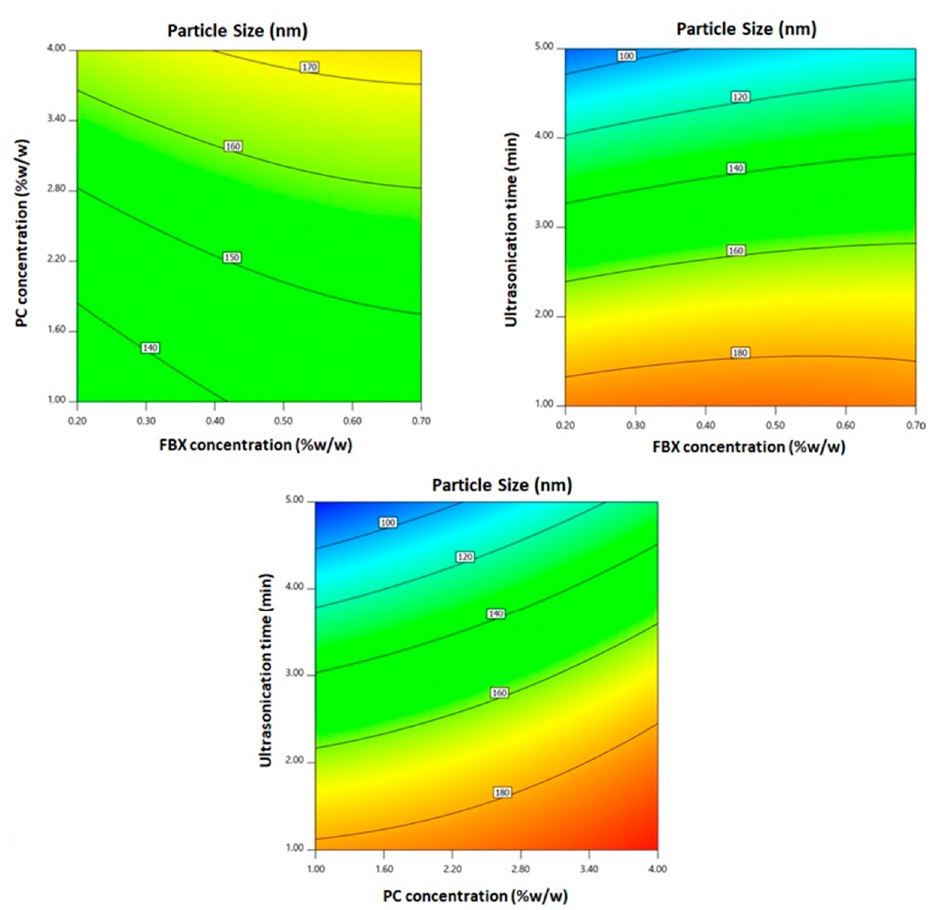
Figure 2. 2D-contour plots for the e ff ect of FBX concentration (X 1 ), PC concentration (X 2 ), and ultrasonication time (X 3 ) on the particle size of